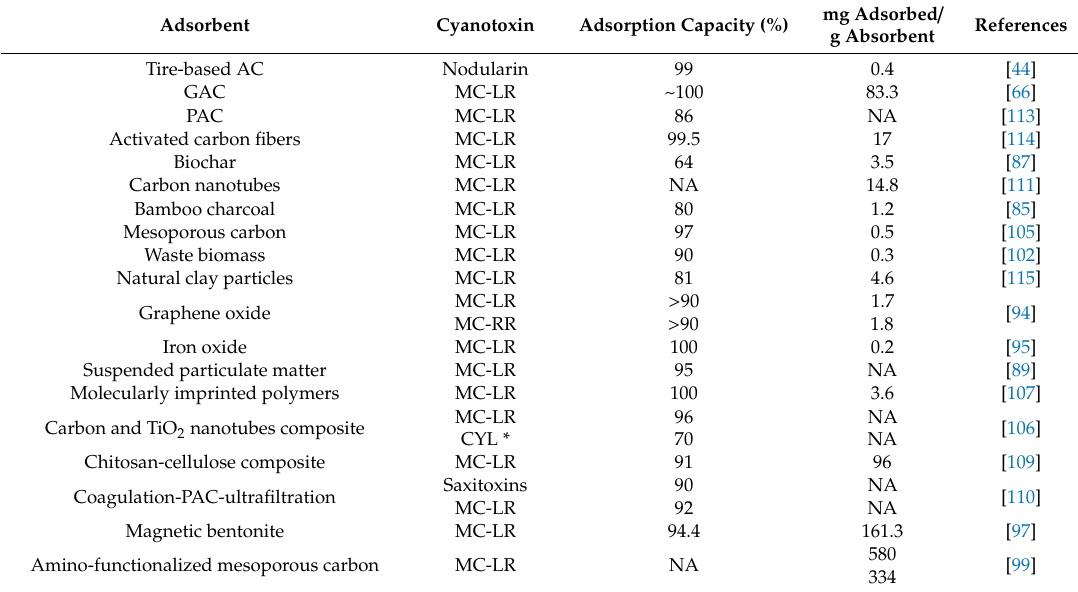
Table 5. Comparative analysis of cyanotoxin adsorption on several